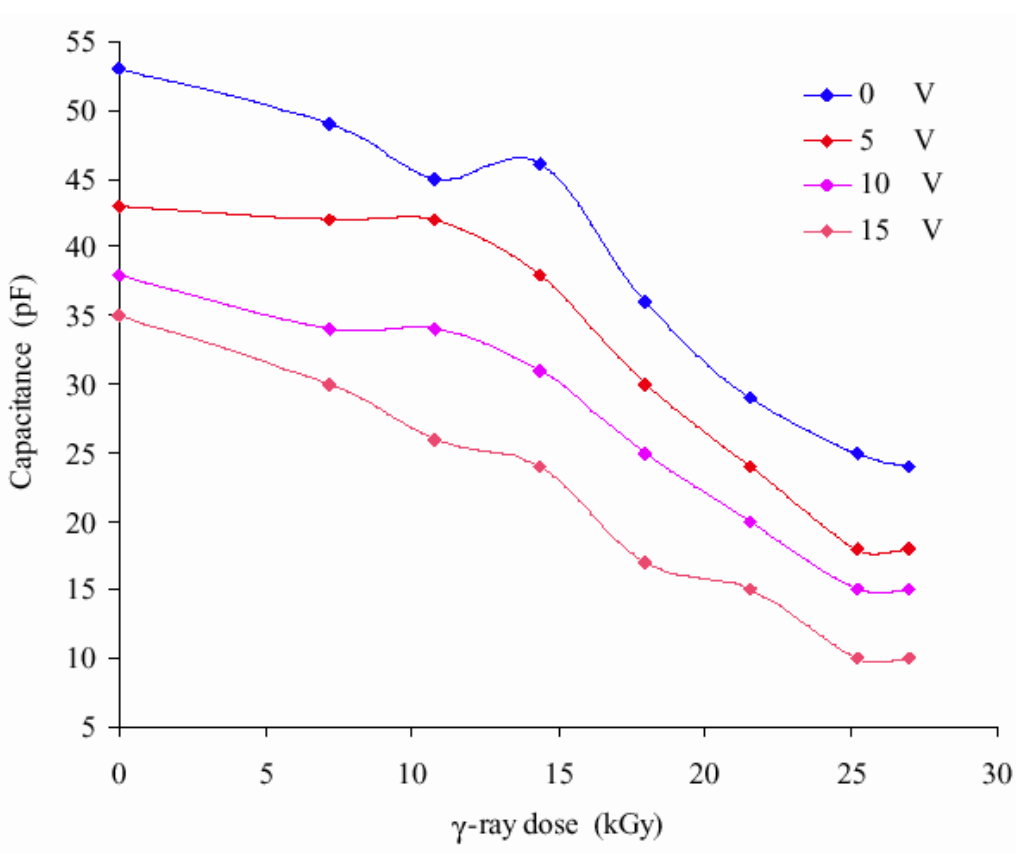
Figure 8. The decrease in the capacitance as with the increase in γ -ray